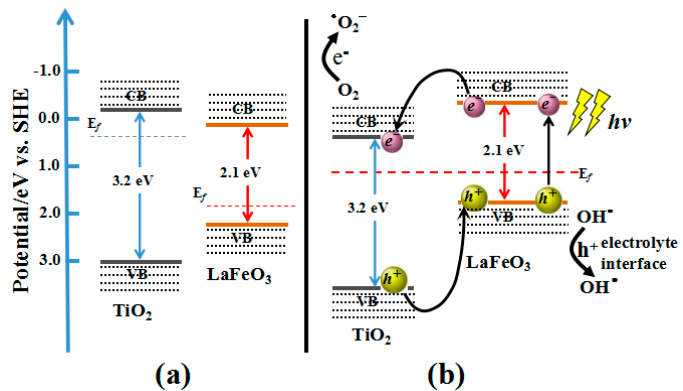
Figure 7. Schematic diagram showing the separation and transfer of charge carriers of p-LaFeO 3 and n-TiO 2 under visible light irradiation: ( a ) before and ( b ) after Fermi level reach equilibrium.